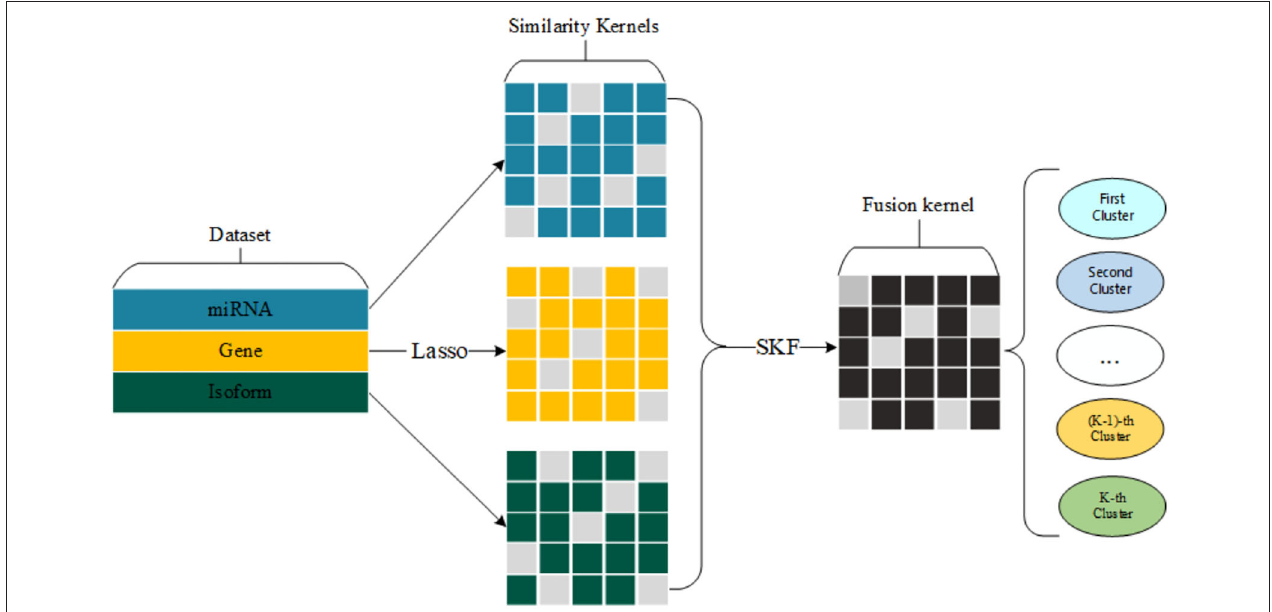
FIGURE 1 | Flow chart of our proposed method for detecting cancer subtypes.